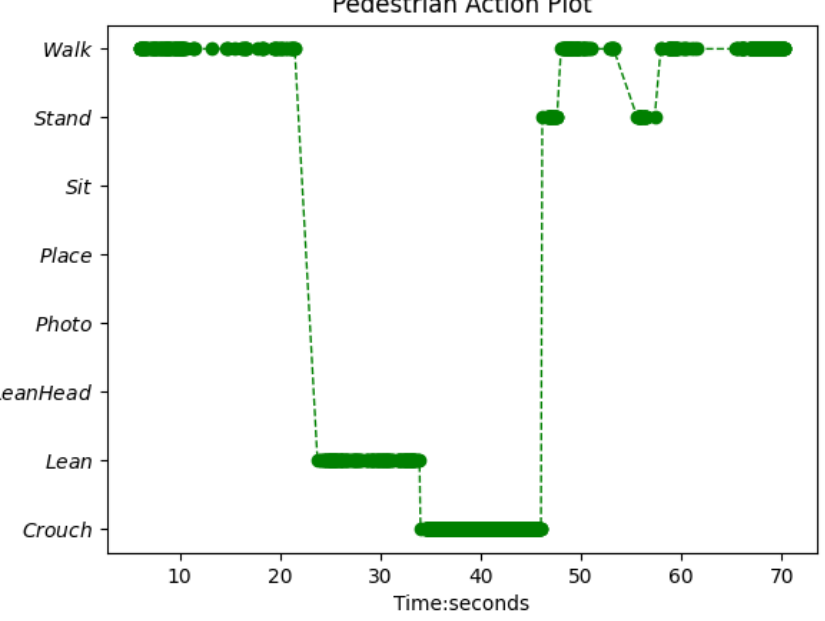
Figure 4. Action graph of test clip 13. As the prediction is frame-wise, there are void time-points in between where the actions at the time-points were not recognised due to low